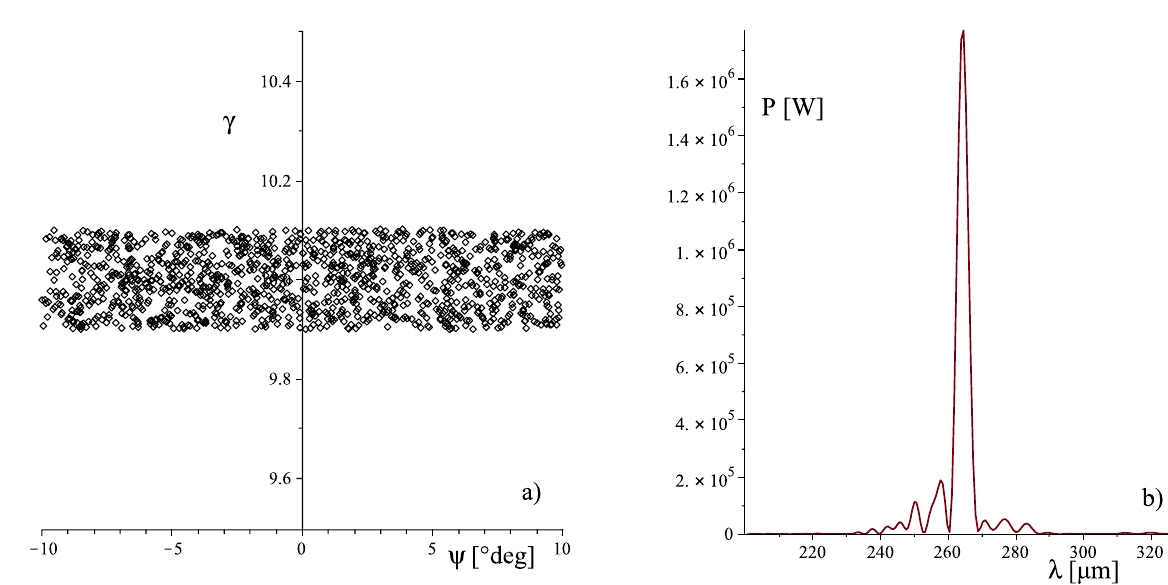
Figure 6. Emission by undulator – radiator: modulated case: ( a ) phase-space; and ( b ) power spectrum.